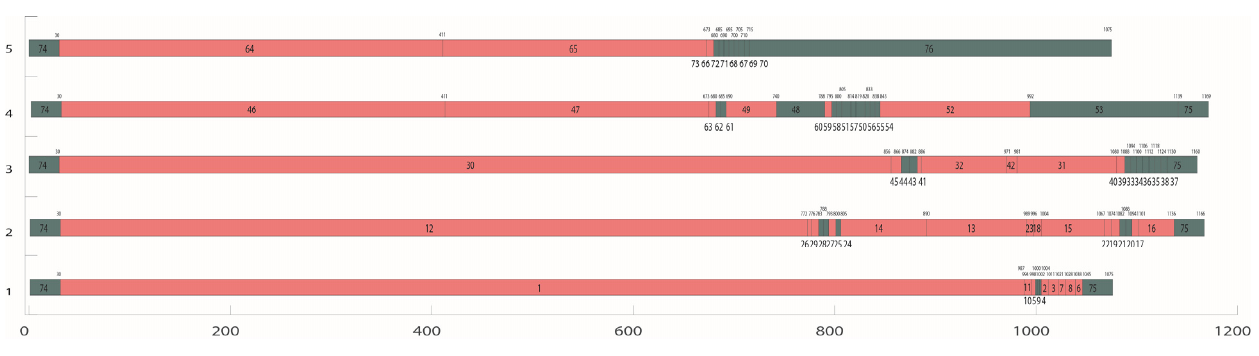
Figure 11. Task assignment Gantt chart for cadence time 1170.